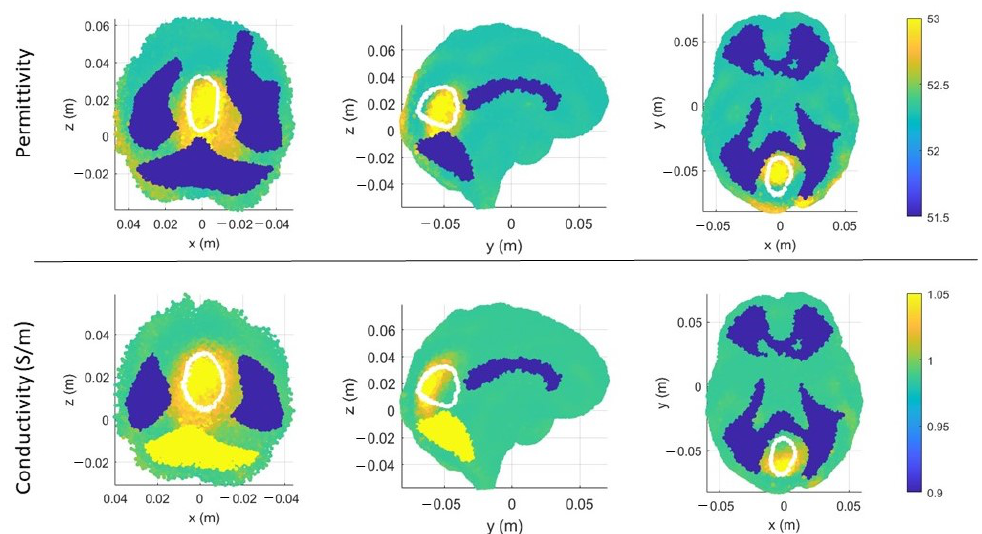
Figure 8. CSI algorithm results with the proposed discretization. Shape, position, and dielectric properties values of the stroke identified by the CSI algorithm after 100 iterations. On the first row, three different views of the permittivity, and on the second row, three different views of the conductivity. The perimeter of the expected stroke shape is shown in